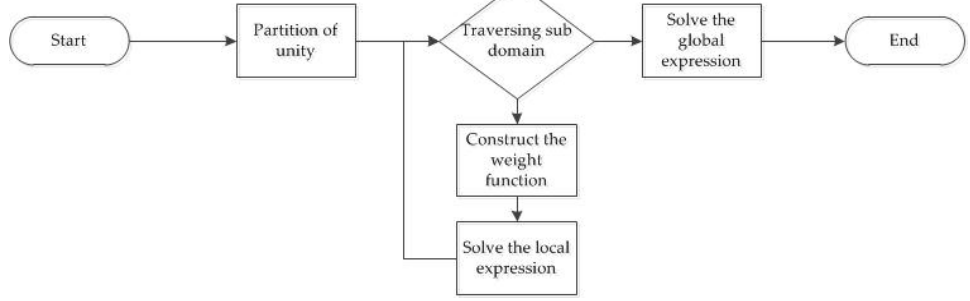
Figure 3. The KDFcmPUM process.